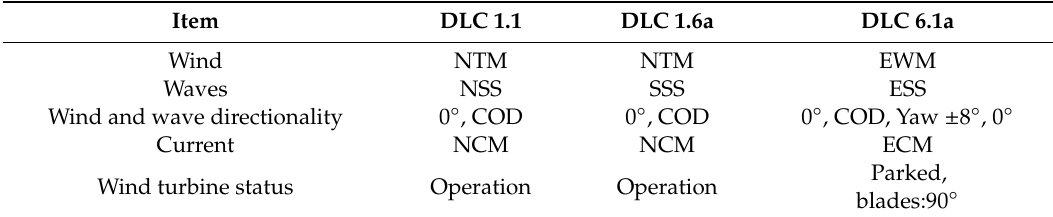
Table 3. Design Load Cases (DLCs) [25].